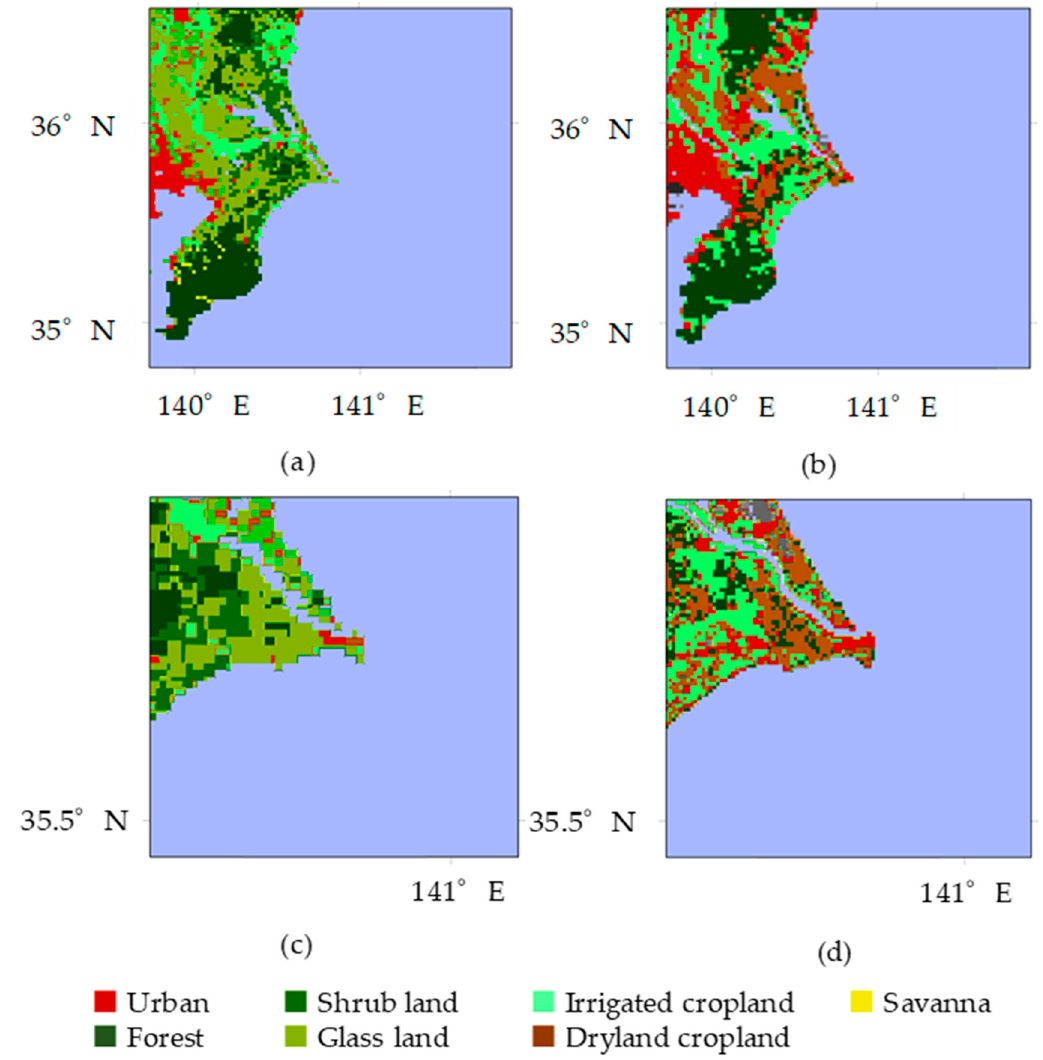
Figure 8. The land-use data sets applied in this study in the innermost domain: the wide-area map of ( a ) USGS ( b ) NLID and the detailed map of ( c ) USCS ( d ) NLID.